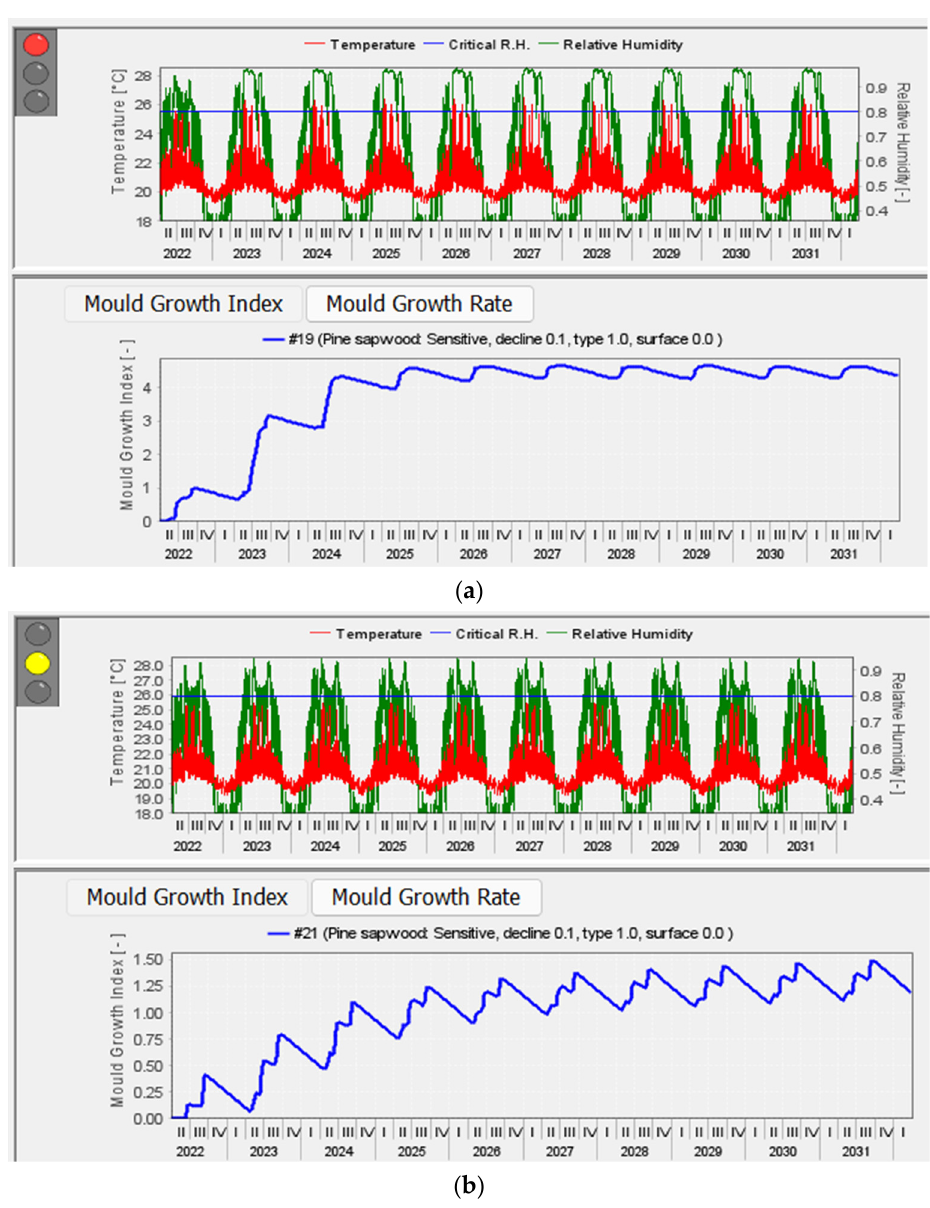
Figure 21. ( a ) Mould Growth Index graph for the wall assembly with single point resistivity value of membrane C in west orientation of cold Holzkirchen climate; ( b ): Mould Growth Index graph for the wall assembly with multipoint resistivity value of membrane C in west orientation of cold Holzkirchen climate.